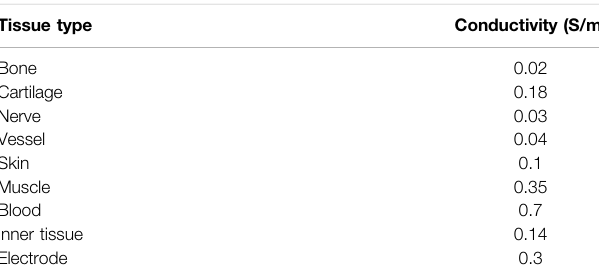
TABLE 1 | Conductivity of each tissue in the model. S (siemens) is the SI derived unit of electric conductance. Tissue